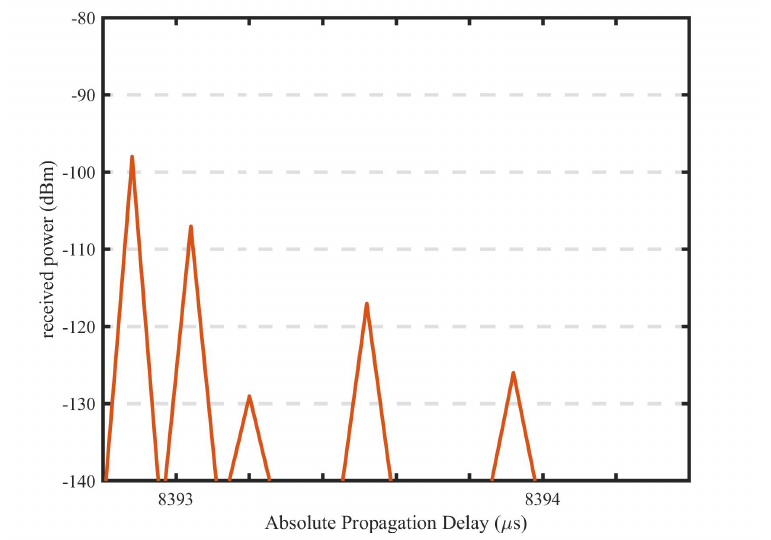
Figure 11. Example of a single measured